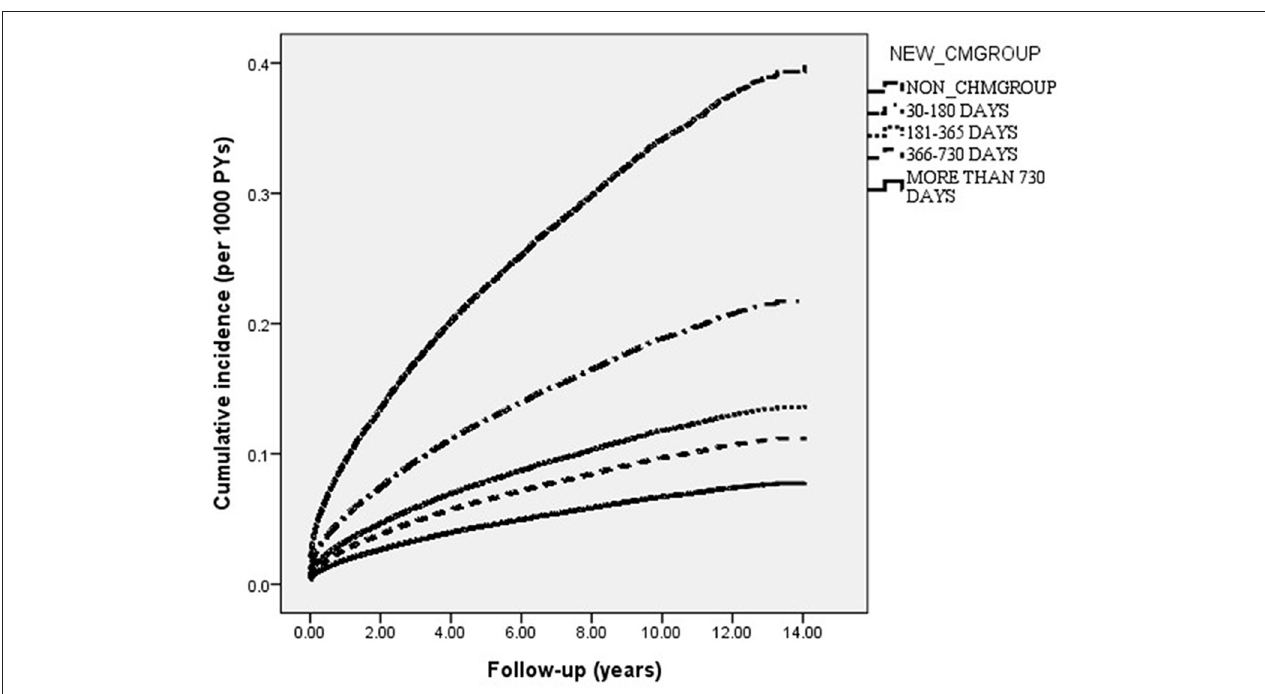
FIGURE 2 | Cumulative incidence of depression in insomnia patients with and without receiving CHMs treatment during the 15-year study period (Log-rank test, P < 0.001).